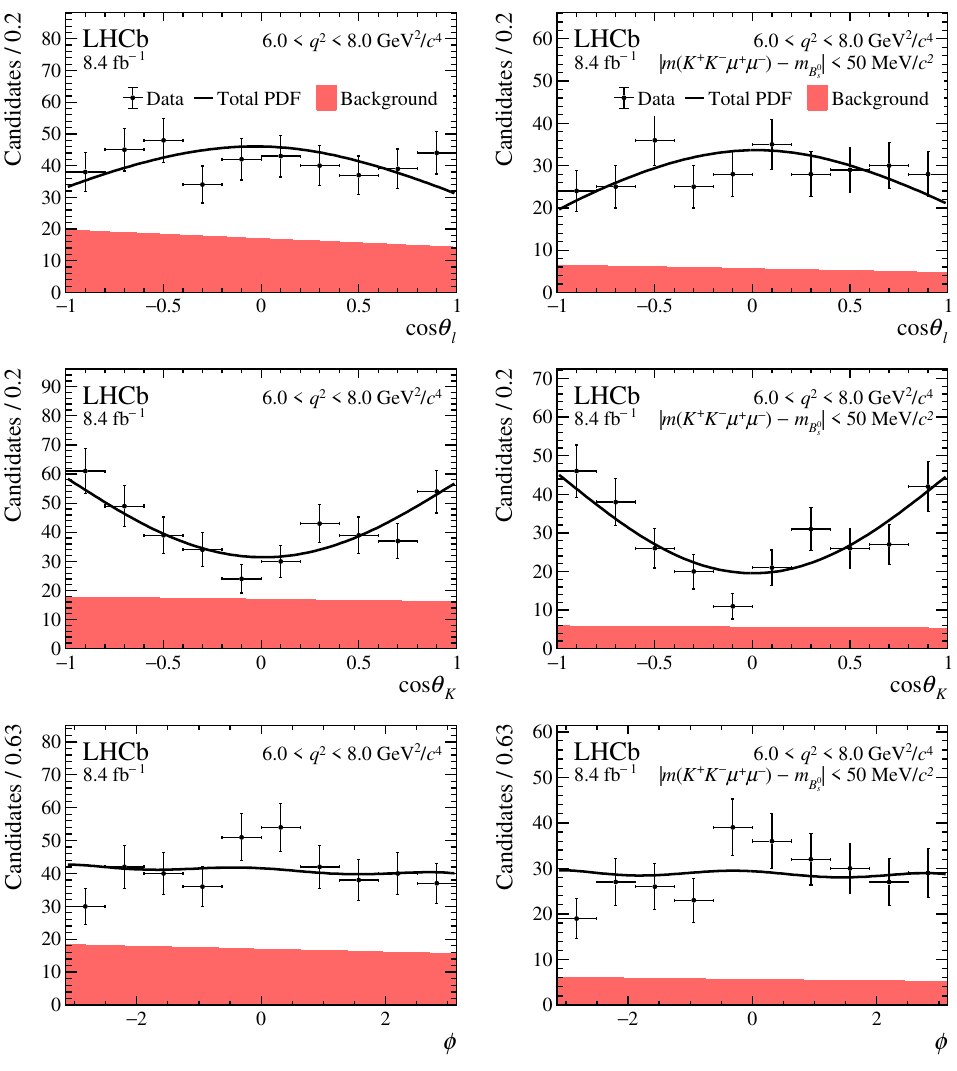
Figure 8 . Projections in the region 6 . 0 < q 2 < 8 . 0 GeV 2 /c 4 for the angular distributions of the combined 2011–2012, 2016 and 2017–2018 data sets. The data are overlaid with the projection of the combined PDF. The red shaded area indicates the background component and the solid black line the total PDF. The angular projections are given for candidates in (left) the entire mass region used to determine the observables in this paper and (right) the signal mass window ± 50 MeV/ c 2 around the known B 0 s